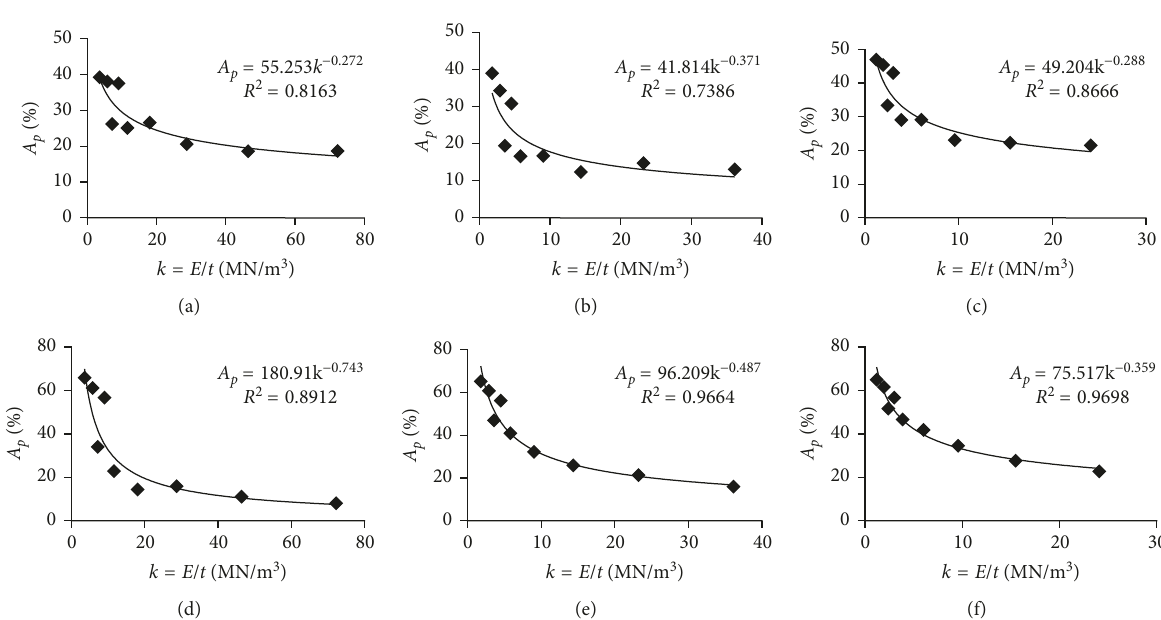
Figure 11: Influence of stiffness of geofoam ( k (d, e, and f) nonyielding retaining wall. (a) H